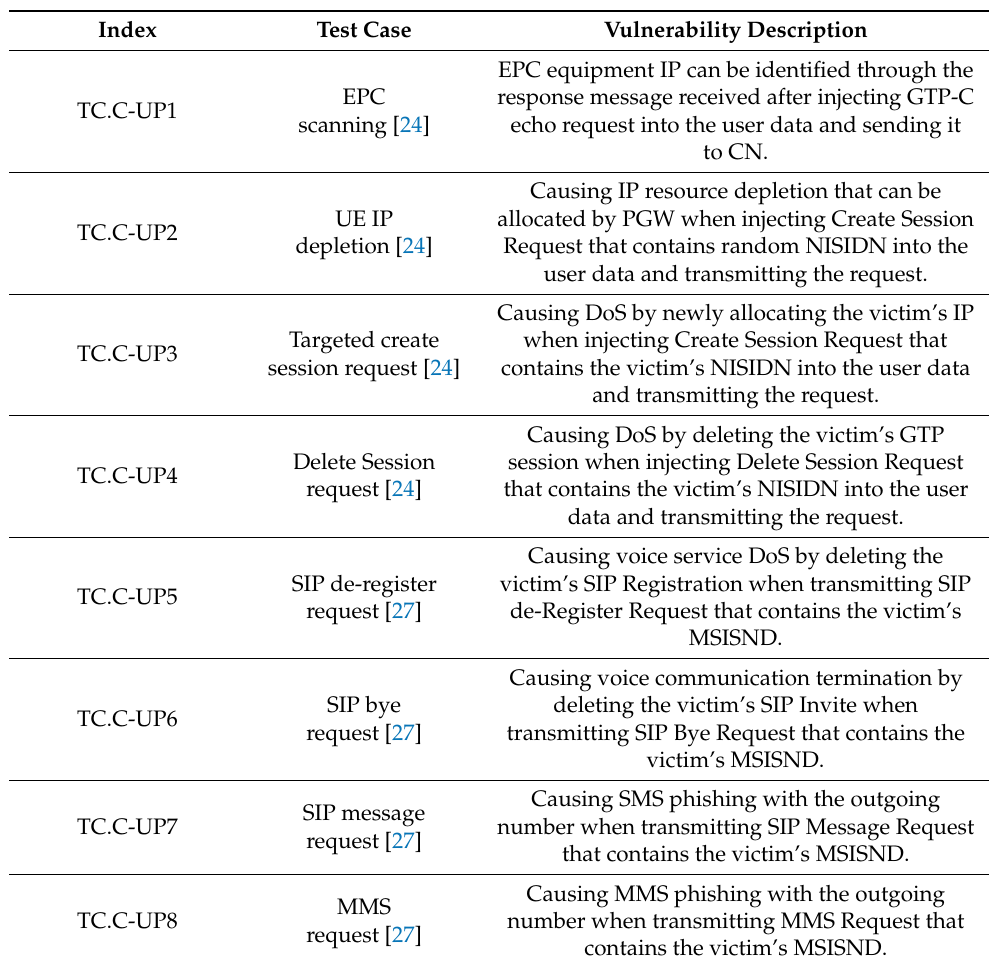
Table 5. CN UP security threat test